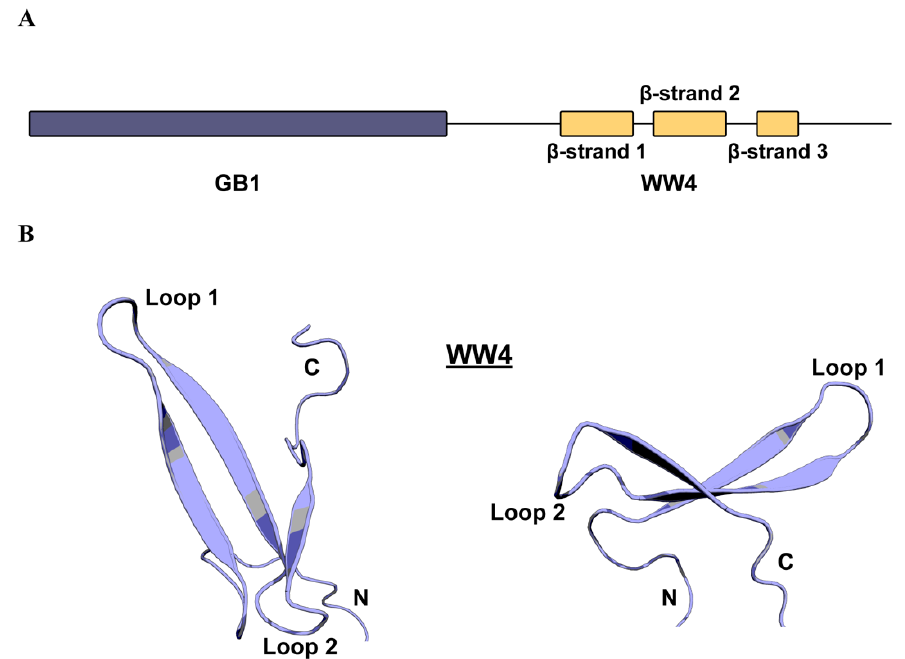
Figure 1. The three-stranded anti-parallel β -sheet structure of WWP2 WW4 solved by NMR. ( A ) A schematic of the B1 domain of streptococcal protein G (GB1)–WW4 recombinant protein. ( B ) Ribbon diagram depictions of the WWP2 WW4 domain from the most representative model (model 1) of the refined 20-model structural ensemble.